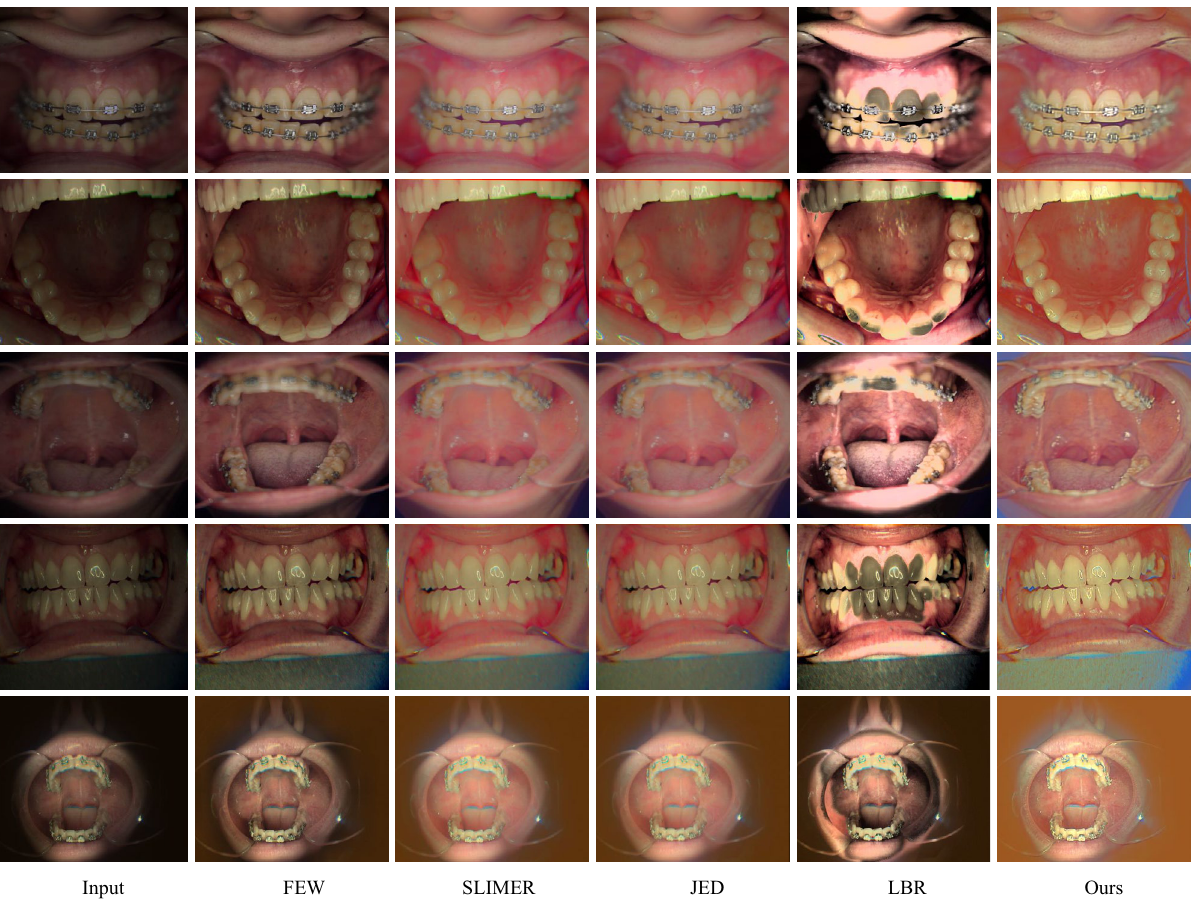
Figure 13. Comparison of our method on input images in the first column with several traditional state-of-the- art approaches.